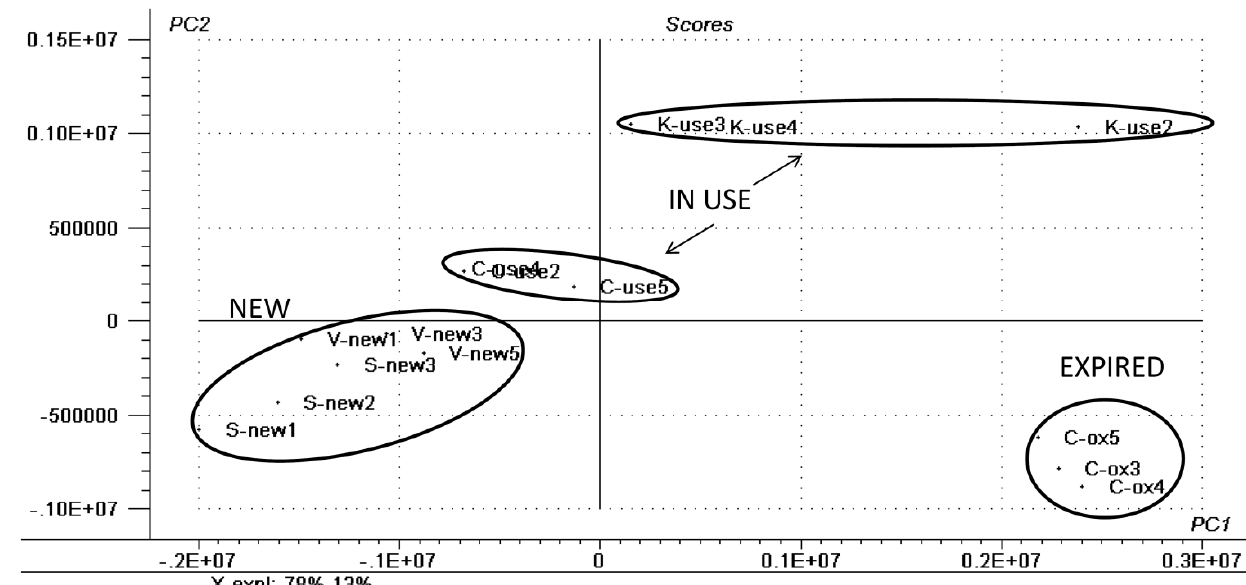
Figure 1. Principal Component Analysis (PCA) score plots showing the different clusters of samples. The three classes (new, in use and expired) are